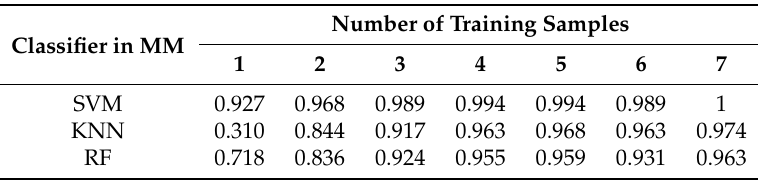
Table 1. Verification accuracy obtained using different classifiers on the contact-based HKPU database. MM: Matching Module.